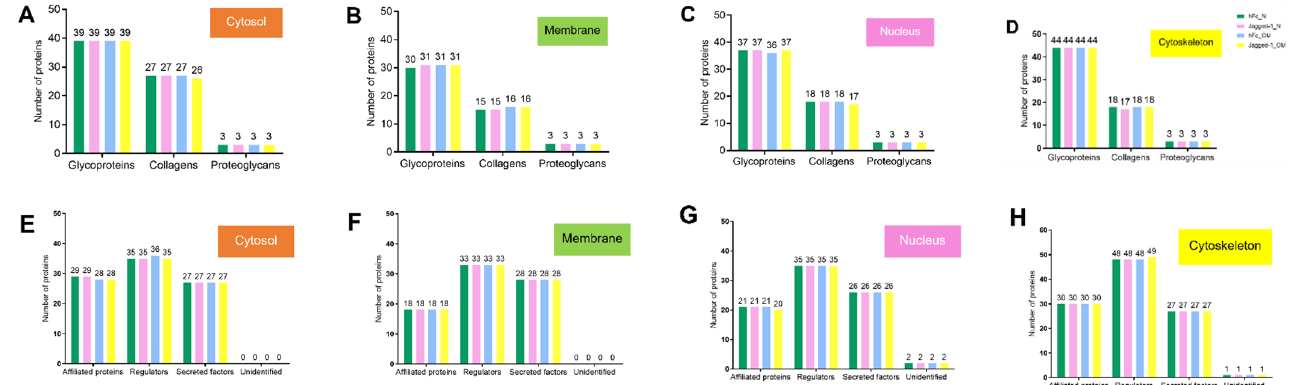
Figure 4. Core matrisome ( A – D ) and matrisome-associated proteins ( E – H ) in the cytosol, membrane, nucleus, and cytoskeleton compartments, respectively. The analyses were performed using the matrisome database downloaded from http://matrisomeproject.mit.edu/other-resources/human-matrisome/, accessed on 25 July 2022.